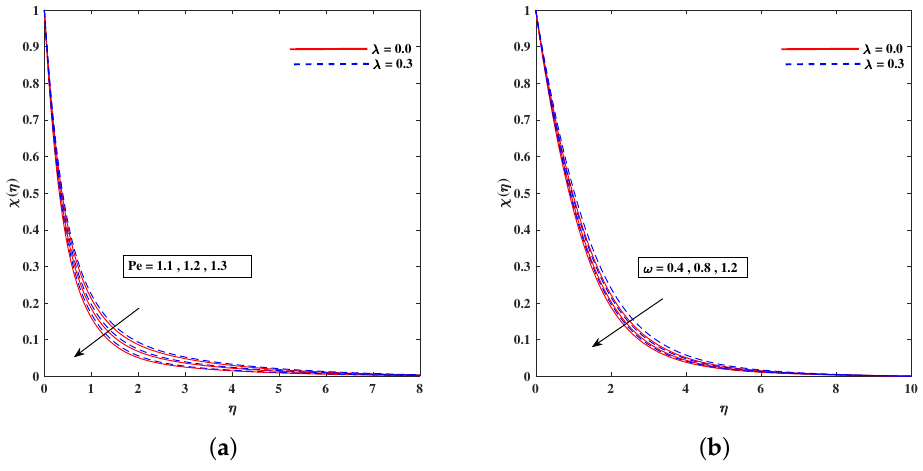
Figure 13. Fluctuation of Pe ( a ) and ω ( b ) on bioconvection profile χ ( η )